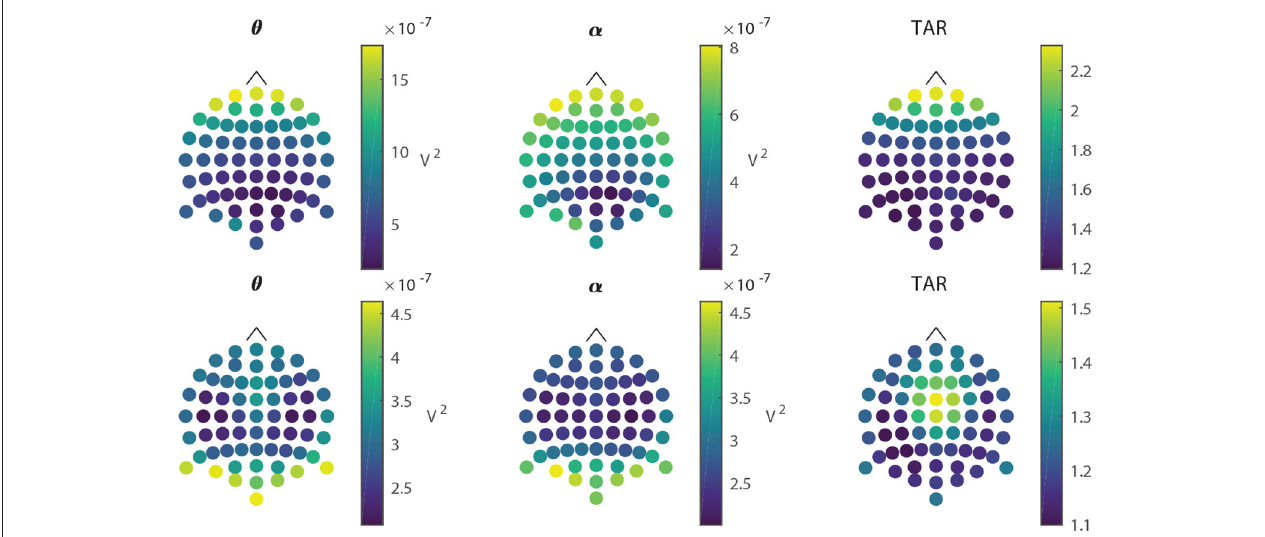
FIGURE 3 | Scalp maps of online and offline data. The upper row shows scalp maps (one dot per electrode) for theta-band power, alpha-band power, and TAR (left-to-right, respectively) from the original data. The lower row shows the same maps computed from the offline data after artifact rejection. Note the differences in scale.